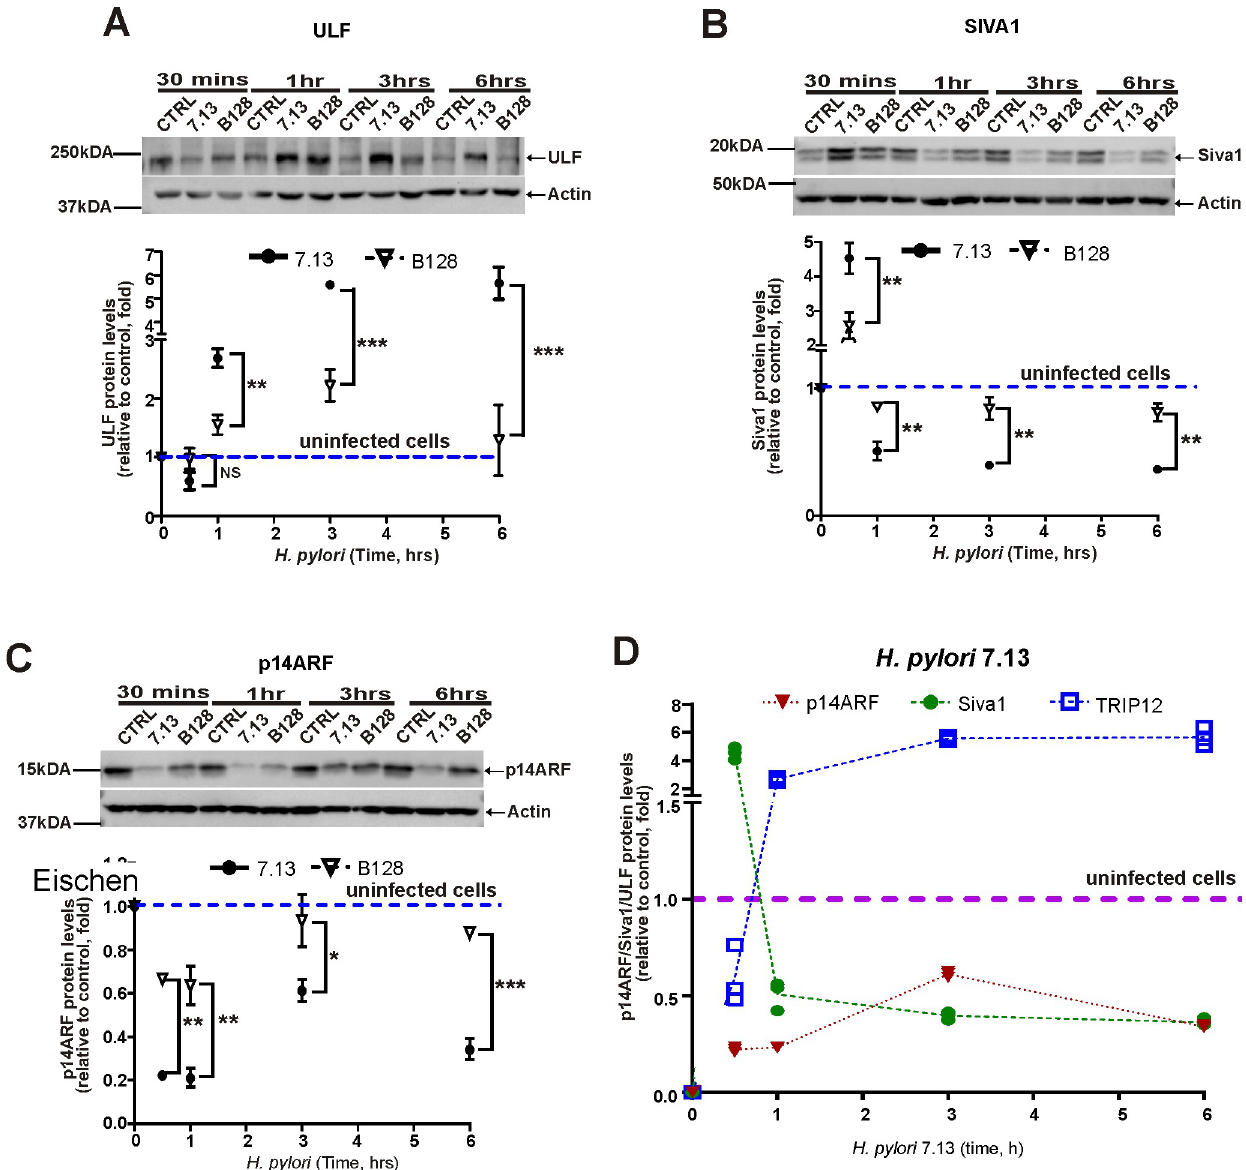
Fig 4. Protein levels of ULF, SIVA1, and p14ARF are dynamically changed in H . pylori -infected cells. Protein expression of ULF (A), SIVA1 (B) and p14ARF (C) in SNU1 cells co-cultured with strains 7.13 or B128 for the indicated time periods. Bottom panels show the densitometric analyses. (D) Temporal dynamics of ULF, SIVA1, and p14ARF proteins in SNU1 cells co-cultured with H . pylori strain 7.13. Statistical analysis was performed using 1-way ANOVA with Tukey’s multiple comparison test. Data are displayed as mean ± SD; n = 3.